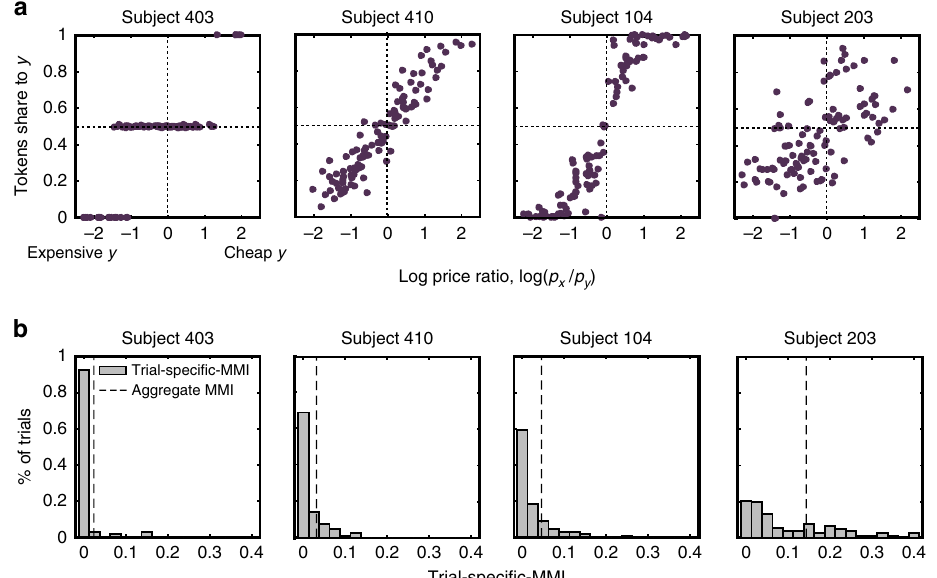
Fig. 4 Representative subjects. a Scatterplots of prominent behaviors: The y -axis represents the share of tokens allocated to the Y account as a function of the log price ratio, log( p x / y ) ( x- axis). As the log price ratio increases, account Y becomes relatively cheaper. Subject 410 equalized expenditures between the two accounts, as she divided tokens proportionally to the price ratio (Cobb – Douglas preferences). Subject 104 exhibited similar behavior, but chose to allocate the entire endowment to the cheaper account in extreme slopes. Subject 403 chose the safe bundle, when the prices of X and Y were relatively similar and allocated most or all her tokens to the cheaper account when the price ratio between the accounts was relatively high (steeper slopes). Even a highly inconsistent subject, like subject 203, was sensitive to changes in prices, with the share of tokens to the Y-account declining as its price rises. b Variability of trial-speci fi c MMI: Distributions of the trial-speci fi c MMI for the four representative subjects from panel a showcase the heterogeneity of trial-speci fi c MMI scores across and within subjects. For example, subject 203 was highly inconsistent throughout most of her trials, while subject 403 was mostly